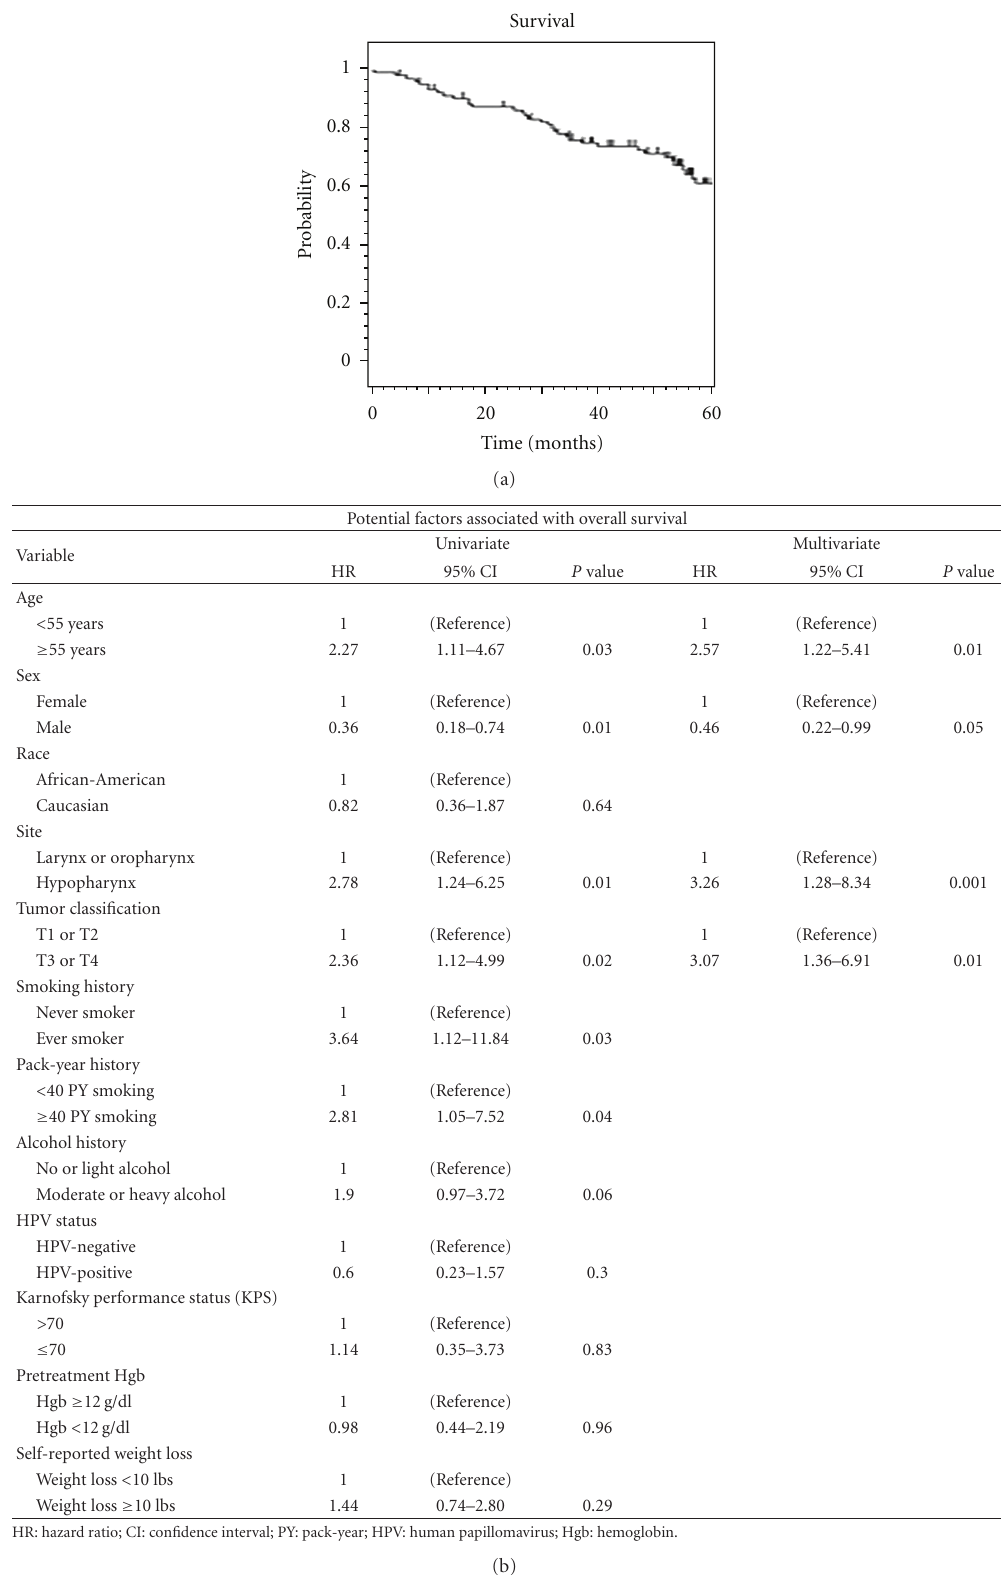
Figure 1: (a) Kaplan-Meier depiction of overall survival for all patients, (b) univariate and multivariate analyses of clinical characteristics potentially associated with overall